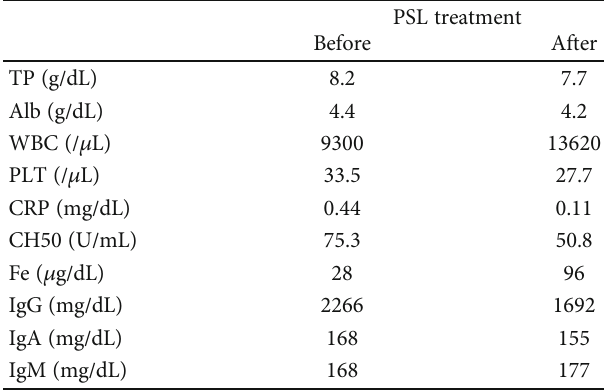
Table 1: Levels of chronic in fl ammatory parameters before and after